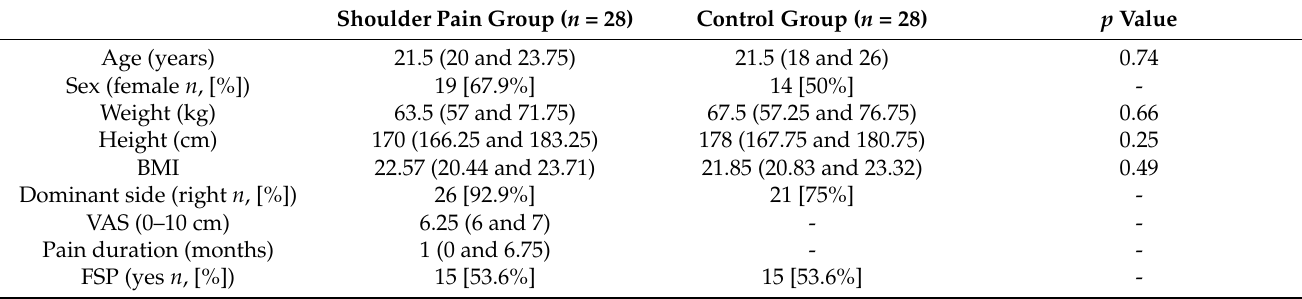
Table 1. Characteristics of the groups. Values are median (first and third quartiles) and n (%).